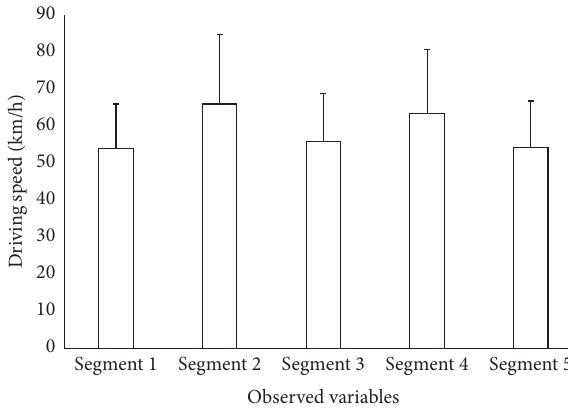
Figure 10: Speed statistics for variables involved in the latent variable “Geometric Design.”